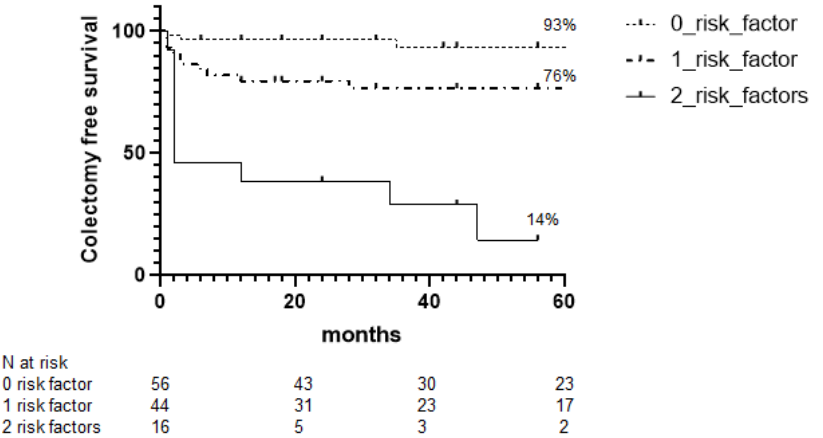
Figure 4. Kaplan–Meier curves of 116 patients with acute severe ulcerative colitis responding to intravenous corticosteroids or infliximab according to risk factors .